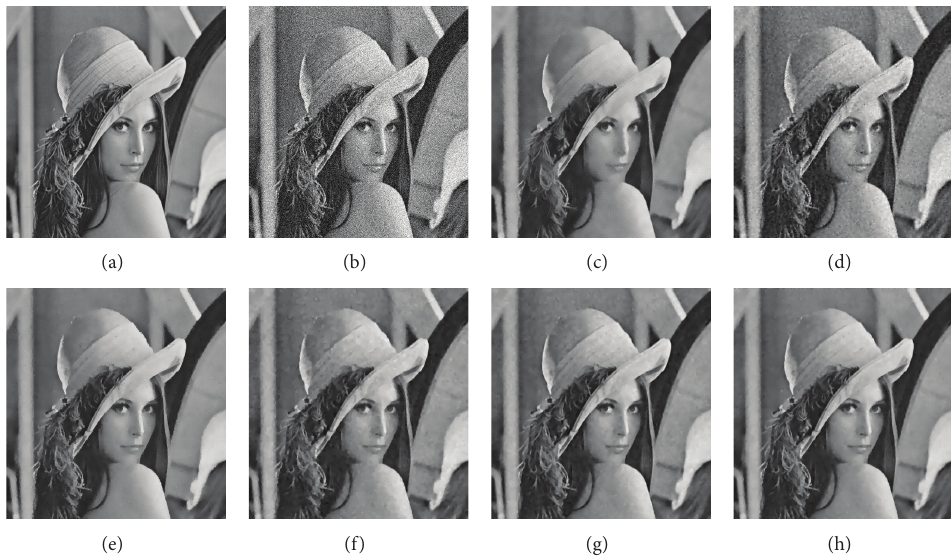
Figure 3: Results of the lena image by the five models: (a) original image, (b) noisy image, (c) result by NLM, (d) result by Y-K model, (e) result by PM, (f) result by TV, (g) result by MTV, and (h) result by our model.